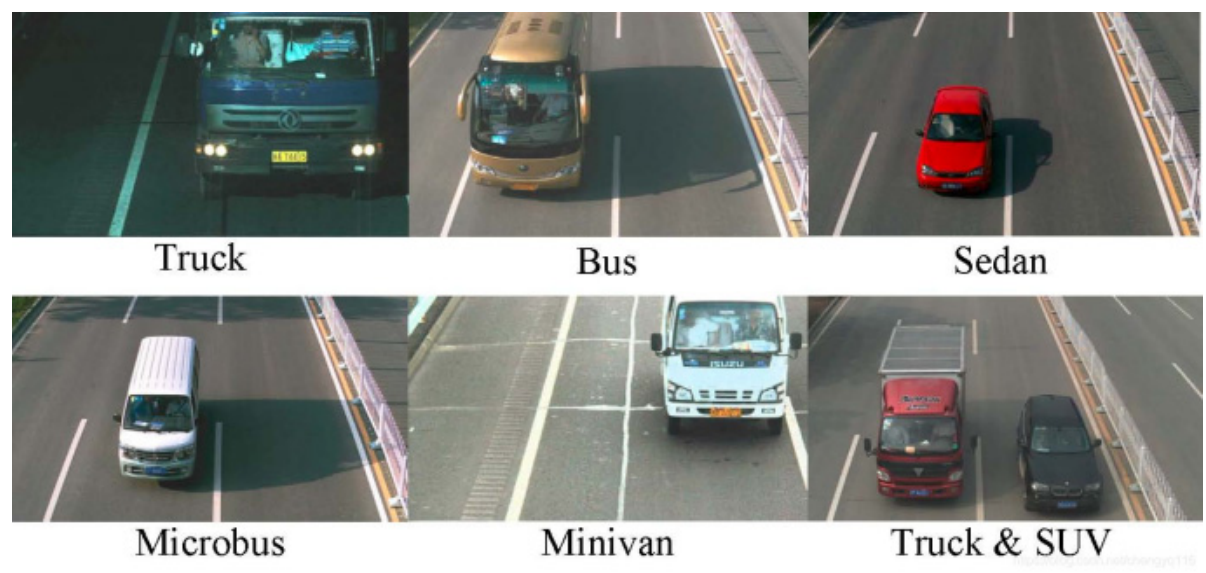
Figure 5. Example of BIT-Vehicles dataset.